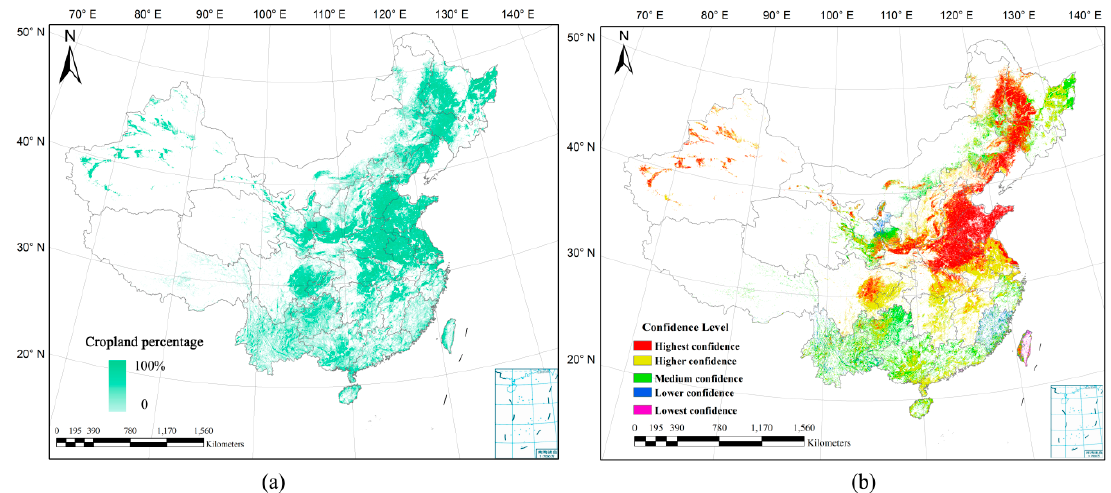
Figure 8. Synergy results based on the five cropland maps: ( a ) cropland percentage map; ( b ) cropland confidence map.